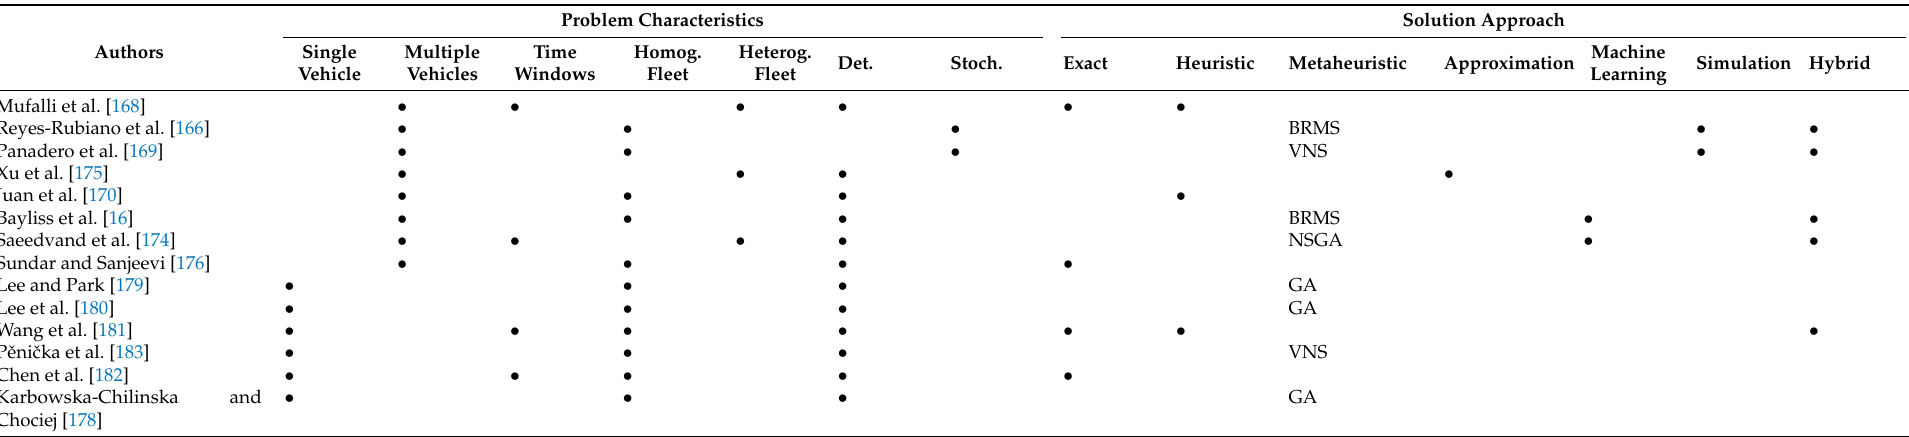
Table 3. Classification of the revised E-TOP papers according to the problem characteristics and the solution